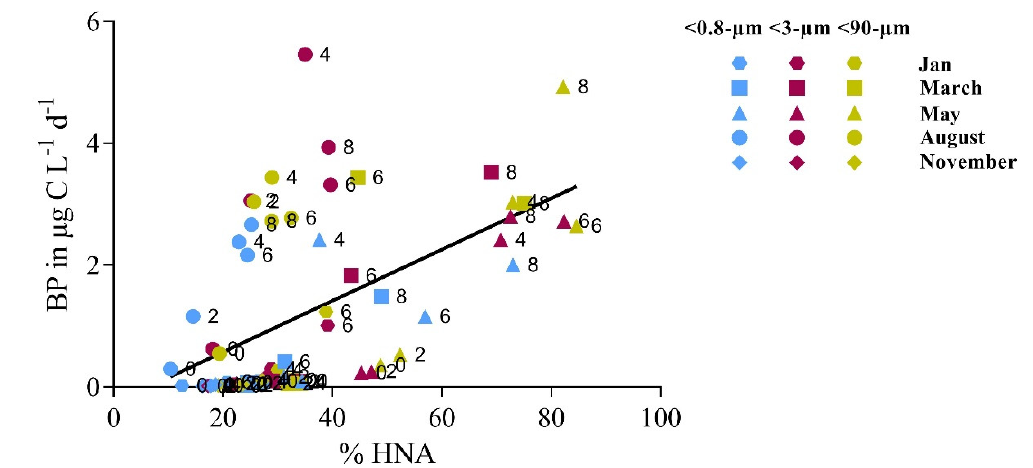
Figure 4. Bacterial production (BP) plotted against the percentage of high nucleic acid bacteria (% HNA) of the total bacteria counts. Numbers next to the data points indicate the time point of the incubation when BP was measured. Colors indicate the different fractions and symbols the different months when the experiments were performed (Spearman’s r : 0.63; Type II regression: p < 0.0001).